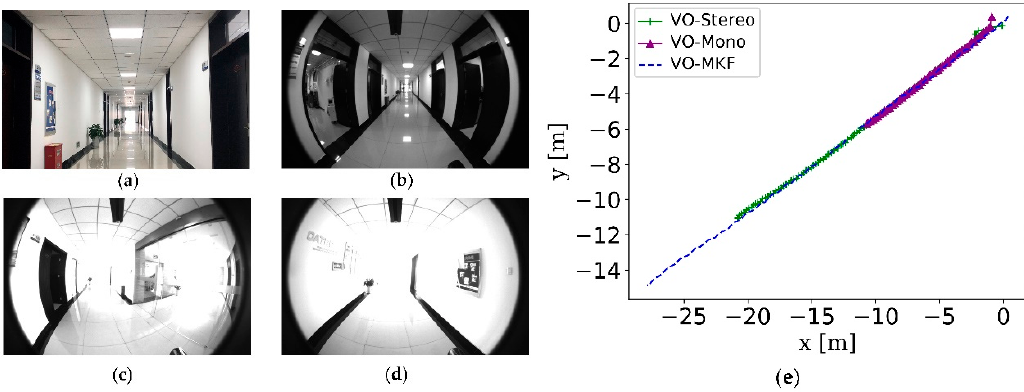
Figure 15. The corridor environment and the comparison trajectories of VO-Mono, VO-Stereo and VO-MKF in corridor environment. The difficult texture-less corridor environment is shown in ( a ) and ( b ), the challenging overexposure condition is shown in ( c ) and ( d ). The comparison trajectories are shown in ( e ).